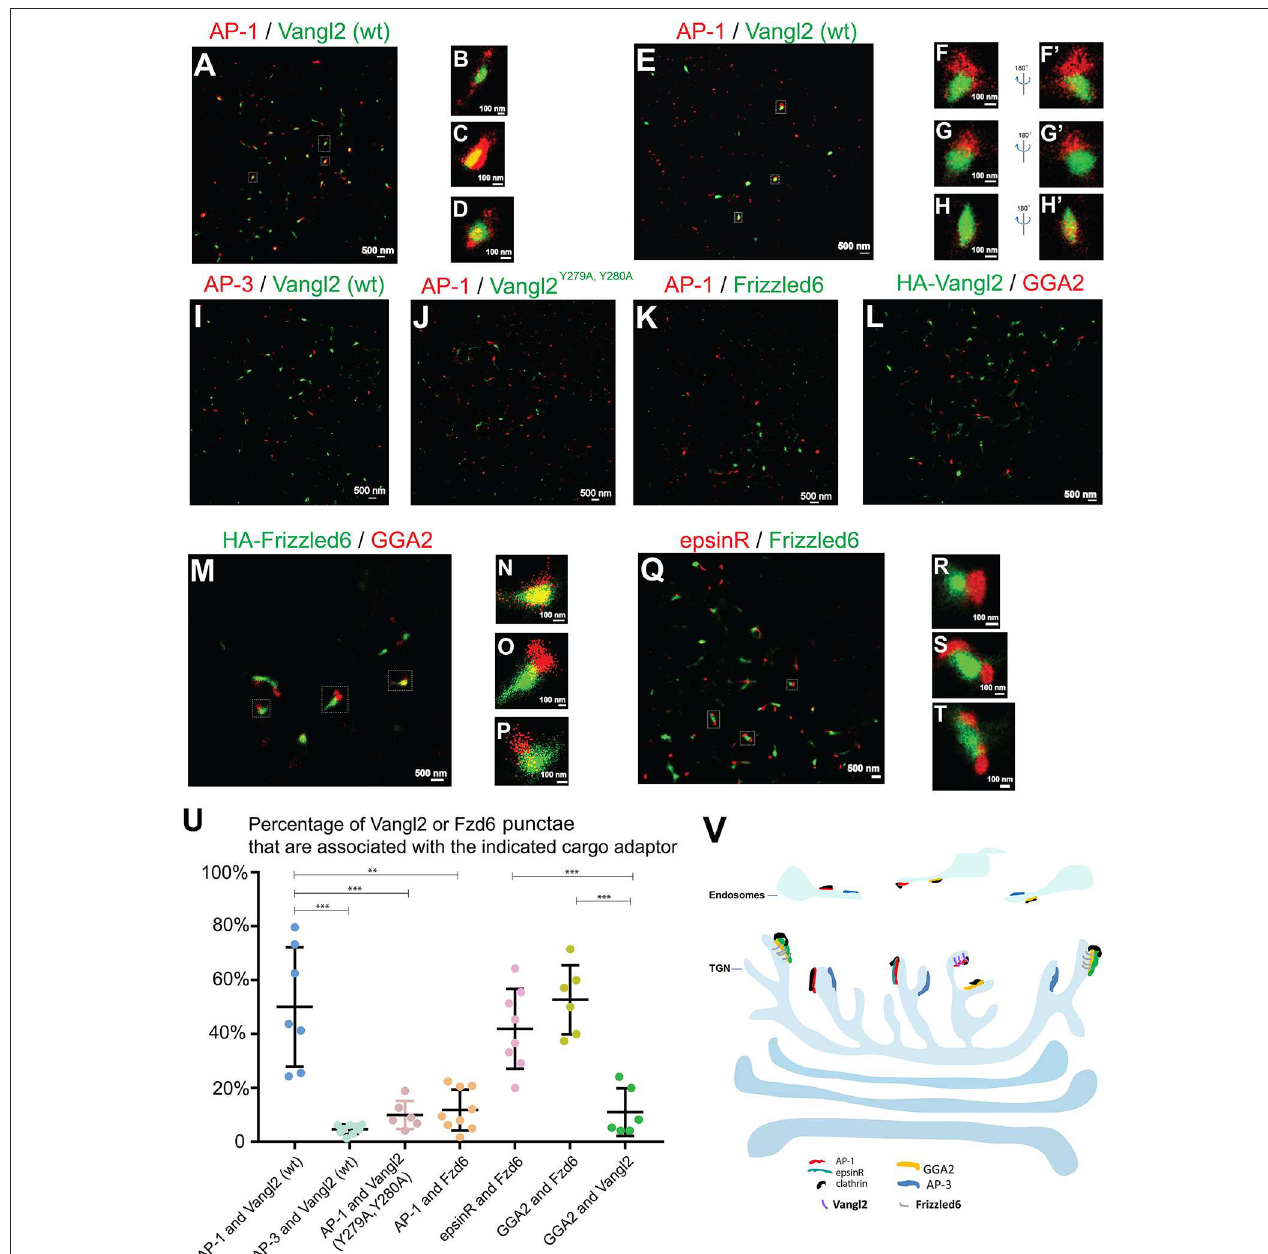
FIGURE 5 | Visualization of sorting of Vangl2 and Frizzled6 upon exiting the TGN through two-color STORM. (A–H’) COS7 cells were transfected with HA-Vangl2 (wt). Day 1 after transfection, cells were incubated at 20 ◦ C for 2h and then at 32 ◦ C for 5min. After incubation, two-color STORM was utilized to visualize localizations of Vangl2 (wt) and the γ subunit of AP-1 at 2-dimension (A–D) and 3-dimension (E–H’) . Magnified views of the indicated areas in (A) were shown in (B–D) . Magnified views of the indicated areas in (E) were shown in (F–H) . 180 ◦ rotated views of the (F–H) were shown in (F’–H’) . The scale bar of each image was indicated. (I–K) COS7 cells were transfected with HA-Vangl2 (wt) or HA-Vangl2 Y279A,Y280A or HA-Frizzled6. Day 1 after transfection, cells were incubated at 20 ◦ C for 2h and then at 32 ◦ C for 5min. After incubation, two-color STORM was utilized to visualize localizations of Vangl2 (wt) and the δ subunit of AP-3 (I) , Vangl2 Y279A,Y280A and the γ subunit of AP-1 (J) , Frizzled6 and the γ subunit of AP-1 (K) . Scale bar, 500nm. (L–Q) COS7 cells were transfected with HA-Vangl2 (L) or HA-Frizzled6 (M–P) or co-transfected with epsinR-FLAG and HA-Frizzled6 (Q–T) . Day 1 after transfection, cells were incubated at 20 ◦ C for 2h and then at 32 ◦ C for 5min. After incubation, two-color STORM was utilized to visualize localizations of Vangl2 and GGA2 (L) , Frizzled6 and GGA2 (M–P) or epsinR-FLAG and Frizzled6 (Q) . Magnified views of the indicated areas in (M,Q) are shown in (N–P,R–T) . (U) Quantifications of the percentage Vangl2 or Frizzled6 punctae that are associated with the indicated cargo